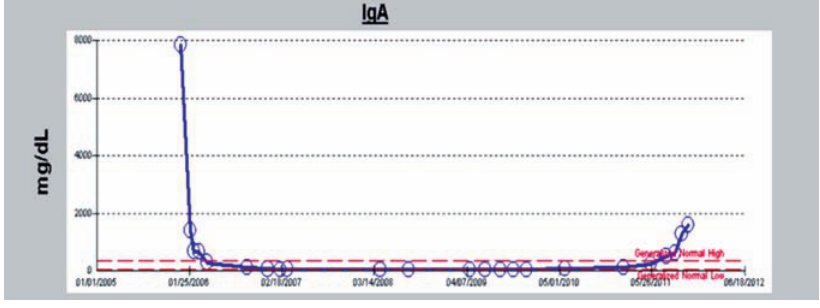
Figure 1. Trend of Immunoglobulin A (IgA) monoclonal protein during